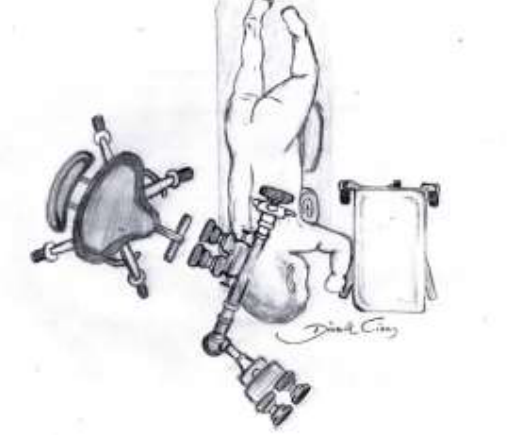
Figure 2. Park bench position for suboccipital approach in infant. A patient positioning and padding. Caution is necessary to avoid brachial plexus